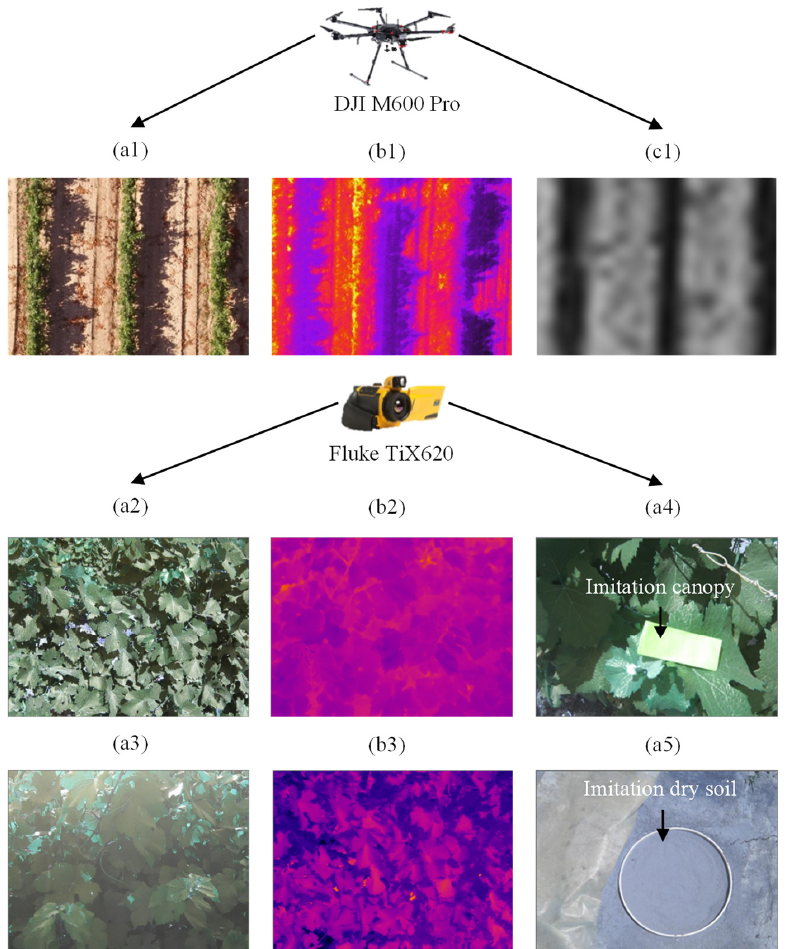
Figure 2. The observation of experimental plot based on UAV and ground remote sensing: ( a1 )–( a5) the visible-light, ( b1 )–( b3 ) thermal infrared, and ( c1 ) multispectral images of vineyard. Specially, ( a4 , a5 ) are the RBG images of imitation canopy and imitation dry soil (see method 2.3.1.).